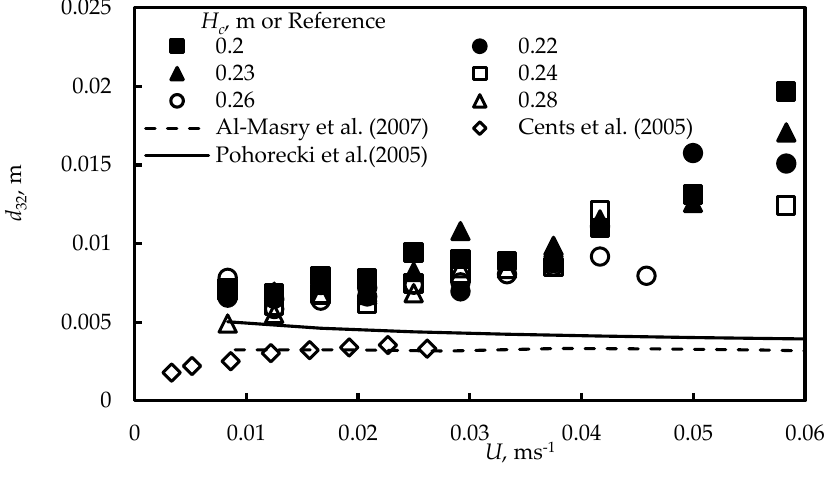
Figure 14. Variation of d 32 as a function of U and H c .